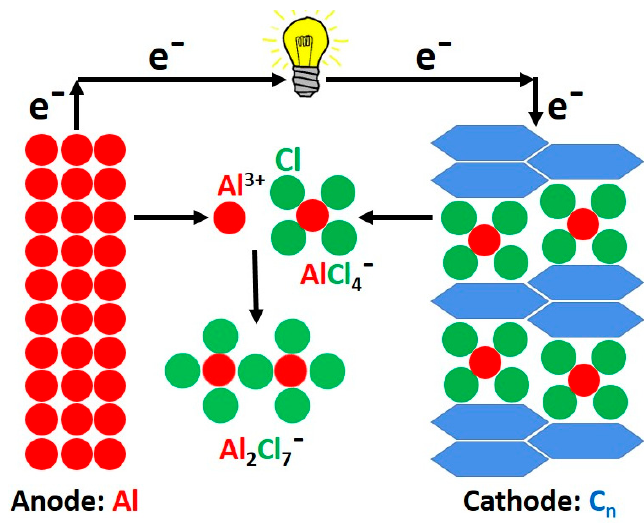
Figure 6. AB discharging in typical AlCl 3 —IL electrolytes.